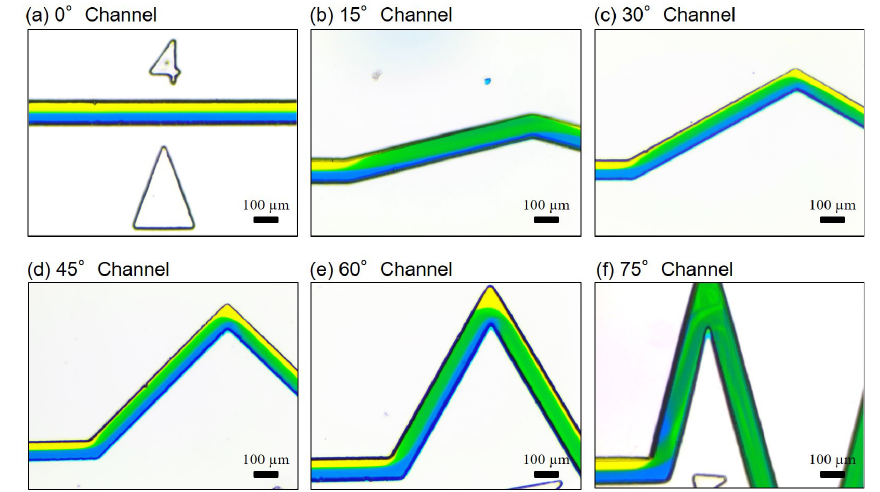
Figure 10. Experimental results of spiral-like advection in different zigzag channels at the flow rate of 1.0 mL/min ( Re = 308.7). ( a ) θ = 0 ◦ . ( b ) θ = 15 ◦ . ( c ) θ = 30 ◦ . ( d ) θ = 45 ◦ . ( e ) θ = 60 ◦ . ( f ) θ = 75 ◦